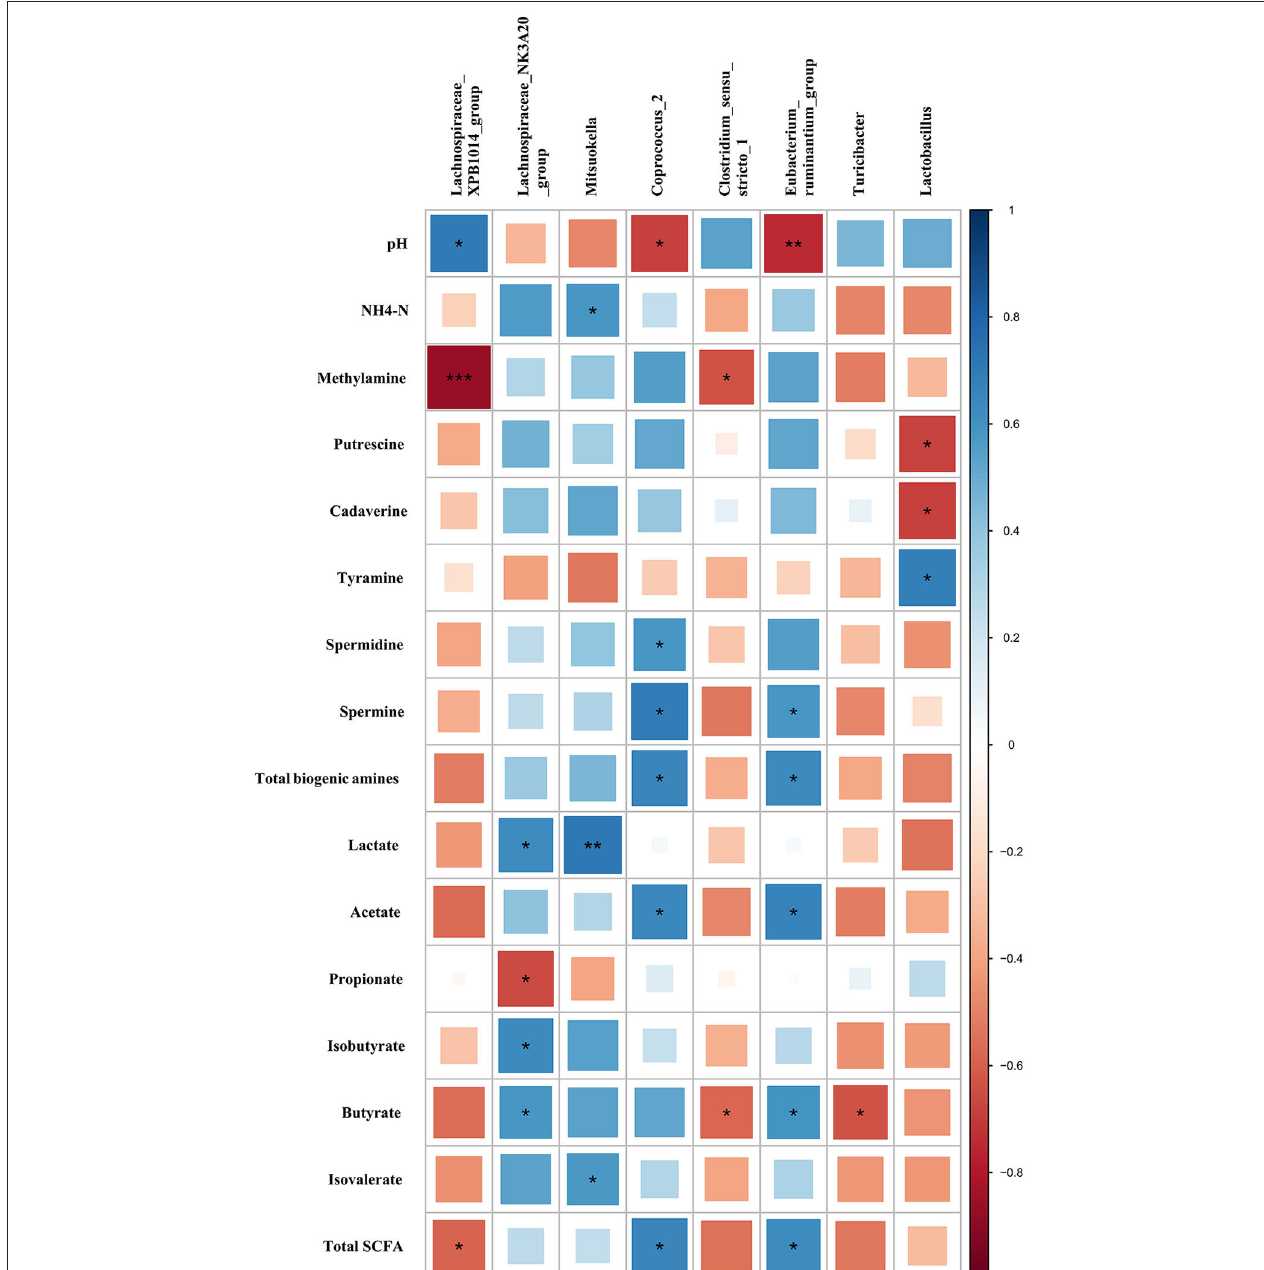
FIGURE 6 | Correlations between the differential microbiota at the genus level with bacterial metabolites in colonic digesta of growing pigs. Each row in the graph represents a pH value and bacterial metabolite (including SCFAs, biogenic amines, lactate, and NH4-N), each column represents a genus, each square represents a Pearson correlation coefficient between a genus and a bacterial metabolite (or pH), while the area of each square represents the size of each correlation coefficient. Red color represents a negative correlation, while blue color represents a positive correlation. ***Indicates a significant difference between the free access group and time-restricted feeding group with P < 0.001; while **, *indicates significant difference with P < 0.01, and P < 0.05 respectively.